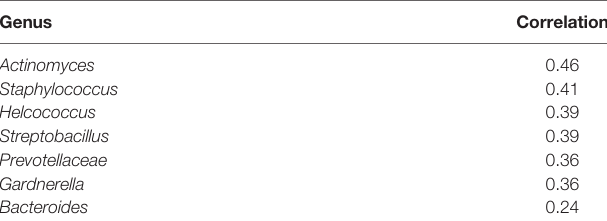
TABLE 5 | Top bacteria correlated with Aerococcus in the UUI vaginal